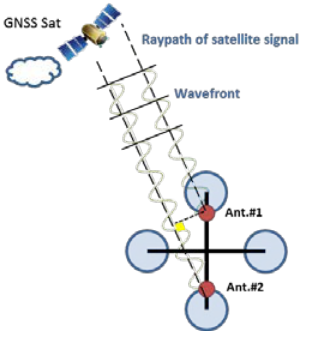
Figure 7: Receiving a waveform from two separated antennas The selected approach for GINSEC project is Double Differencing. For more information, see (Consoli, 2015).